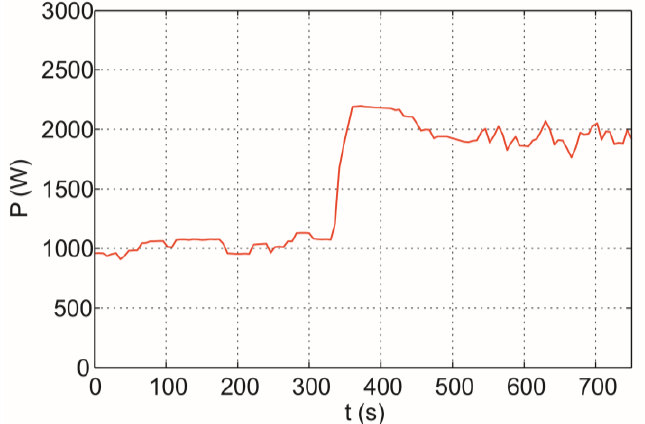
Figure 16. Electrical power at pre-boiling and boiling points.